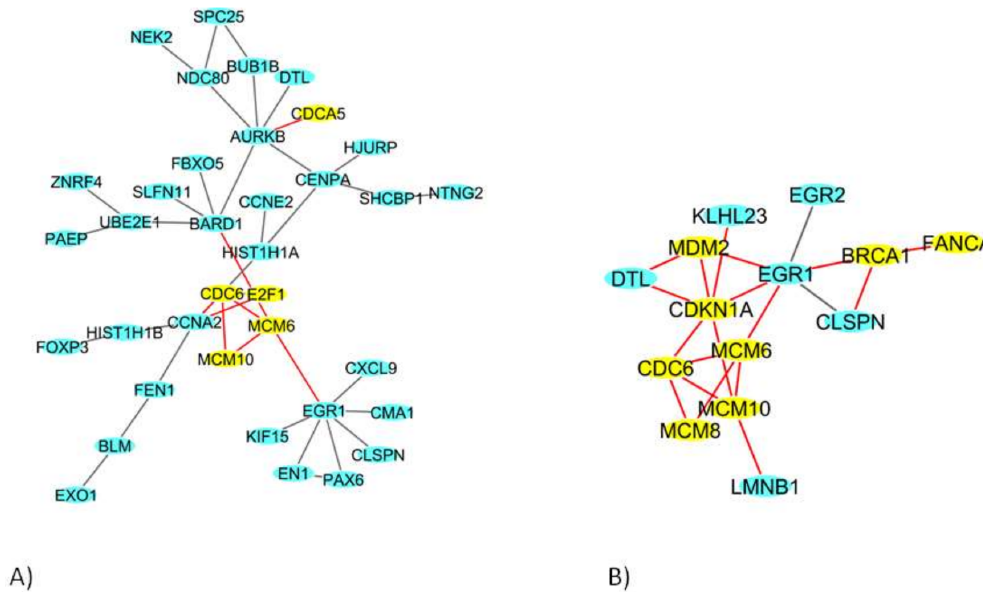
Figure 4. The deregulated densest protein-protein network (blue nodes: proteins, yellow nodes: proteins involved in crucial pathways, red edges: interactions involved yellow nodes) in ( A ) HMEC primary cells and ( B ) BCpc7 BC primary cells: nodes represent genes and edges represent protein